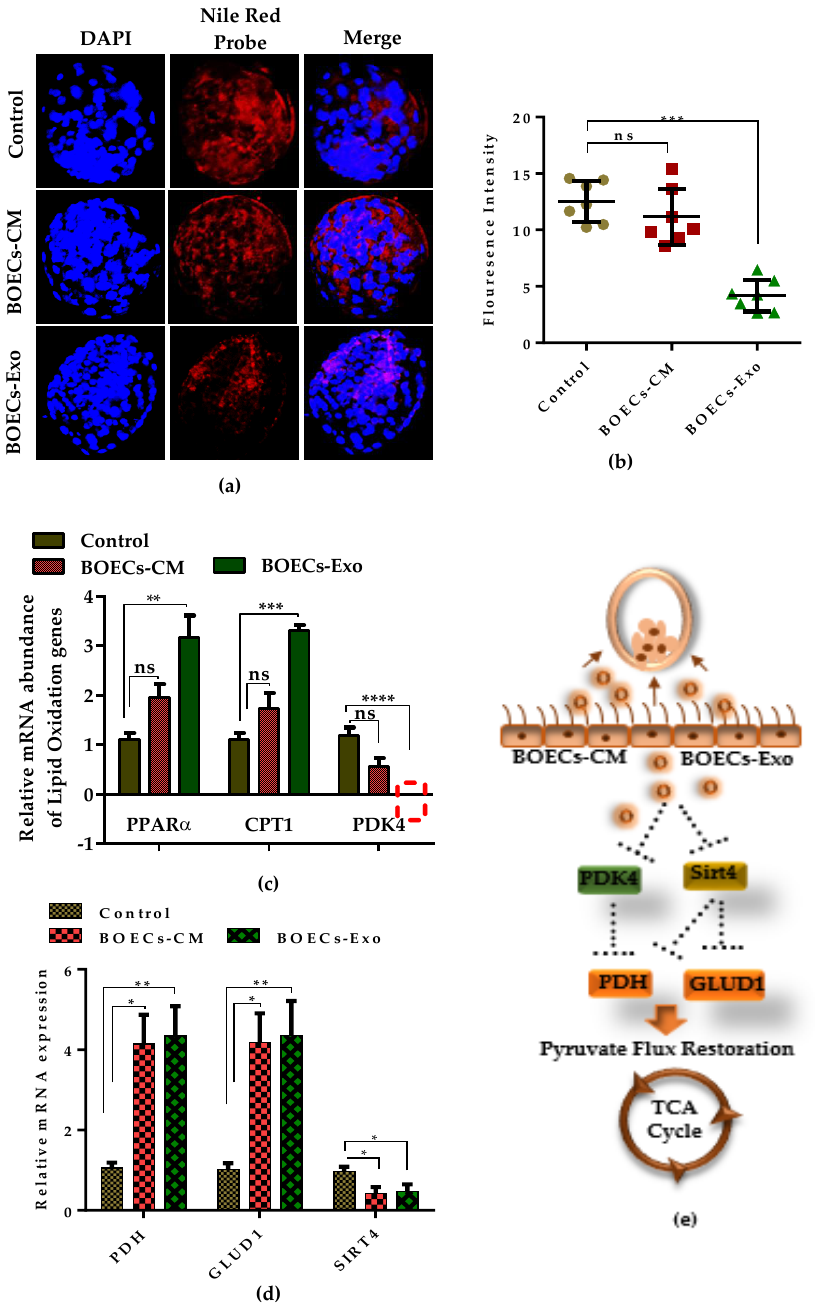
Figure 5. Effect of BOECs-CM and Exo supplementation on utilization of FAO and TCA cycle Figure5. E ff ectofBOECs-CMandExosupplementationonutilizationofFAOandTCAcyclemetabolism metabolism during in vitro culture of bovine embryos. ( a ) Fluorescent Nile probe (red) during in vitro culture of bovine embryos. ( a ) Fluorescent Nile probe (red) staining.displaying the staining.displaying the accumulation of lipid content in day-8 BLs in control, BOECs-CM and Exo accumulation of lipid content in day-8 BLs in control, BOECs-CM and Exo supplemented groups. ( b ) Quantification of fluorescence intensities presented as means ± SEM in each group( n = 20). Original magnification 100 × . ( c , d ) The qRT-PCR analysis presenting the relative mRNA expression of lipid and TCA cycle-metabolizing genes in day-8 BLs cultured in indicated condition. Data in the bar graphs presented as means ± SEM from three independent sets of experiments including ( n = 5) BLs per group in each replicate. * p < 0.05; ** p < 0.01; *** p < 0.001; **** p < 0.0001 denotes significant di ff erence among the groups. ( e ) Hypothetical model illustrates the mechanism of action of BOECs-CM and Exo supplementation e ff ect on developing embryo by utilization of lipids and glucose metabolism. The addition of CM and Exo restore the pyruvate flux into the TCA cycle by blocking its upstream